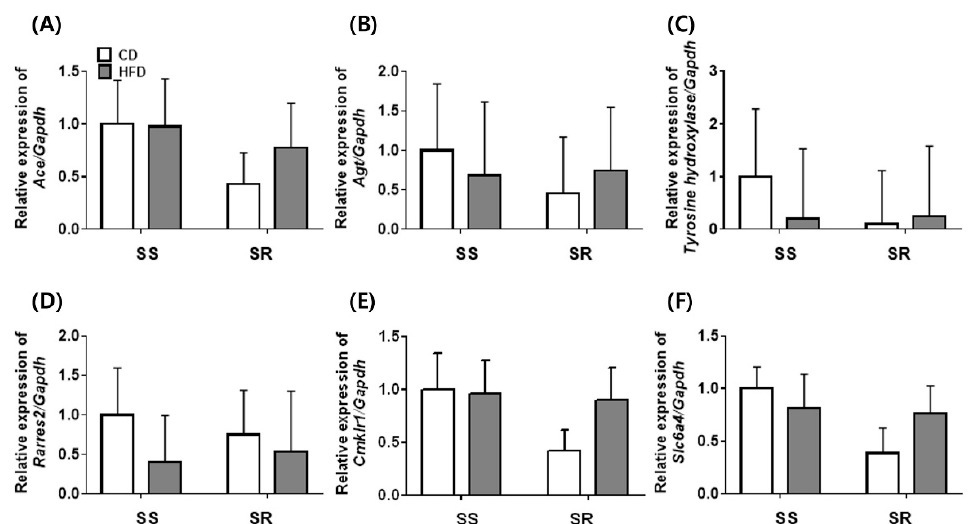
Figure 5. The effects of a high-fat diet on the expression of genes related to contractile factors in PVAT from SS and SR rats. The mRNA expression of angiotensin II-related genes such as angiotensin-converting enzyme ( Ace , A ) and angiotensinogen ( Agt , B ), a norepinephrine-synthesizing gene such as tyrosine hydroxylase ( C ), chemerin-related genes such as rarres2 ( D ) and chemerin receptor 23 ( Cmklr1 , E ), and a serotonin-related gene such as serotonin transporter ( Slc6a4 , F ) were measured by RT-qPCR in PVAT from SS and SR rats fed a CD or HFD for 12 weeks. Graph, mean ± SEM of 6 independent experiments. Two-way analysis of variance followed by Tukey’s post hoc multiple comparisons test.